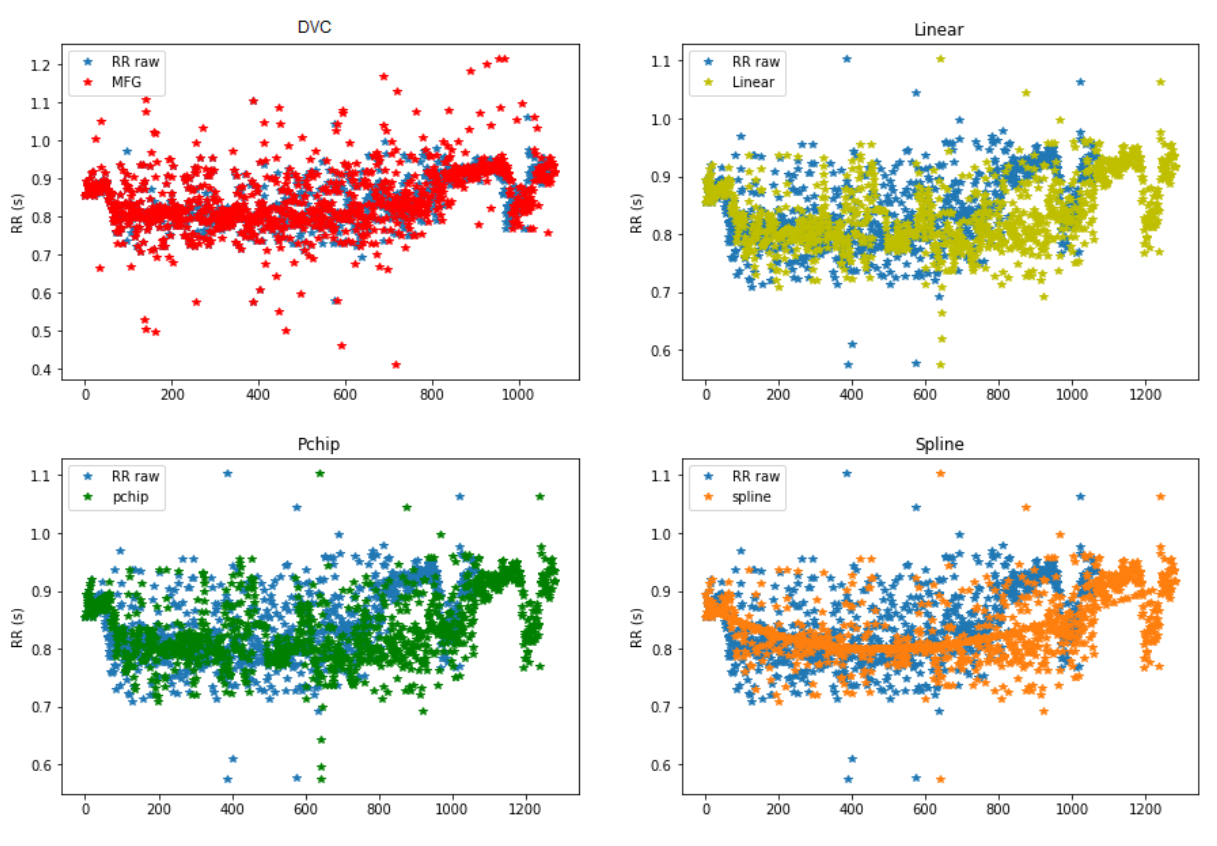
Figure 6. Example of data imputation for 20% deleted data.